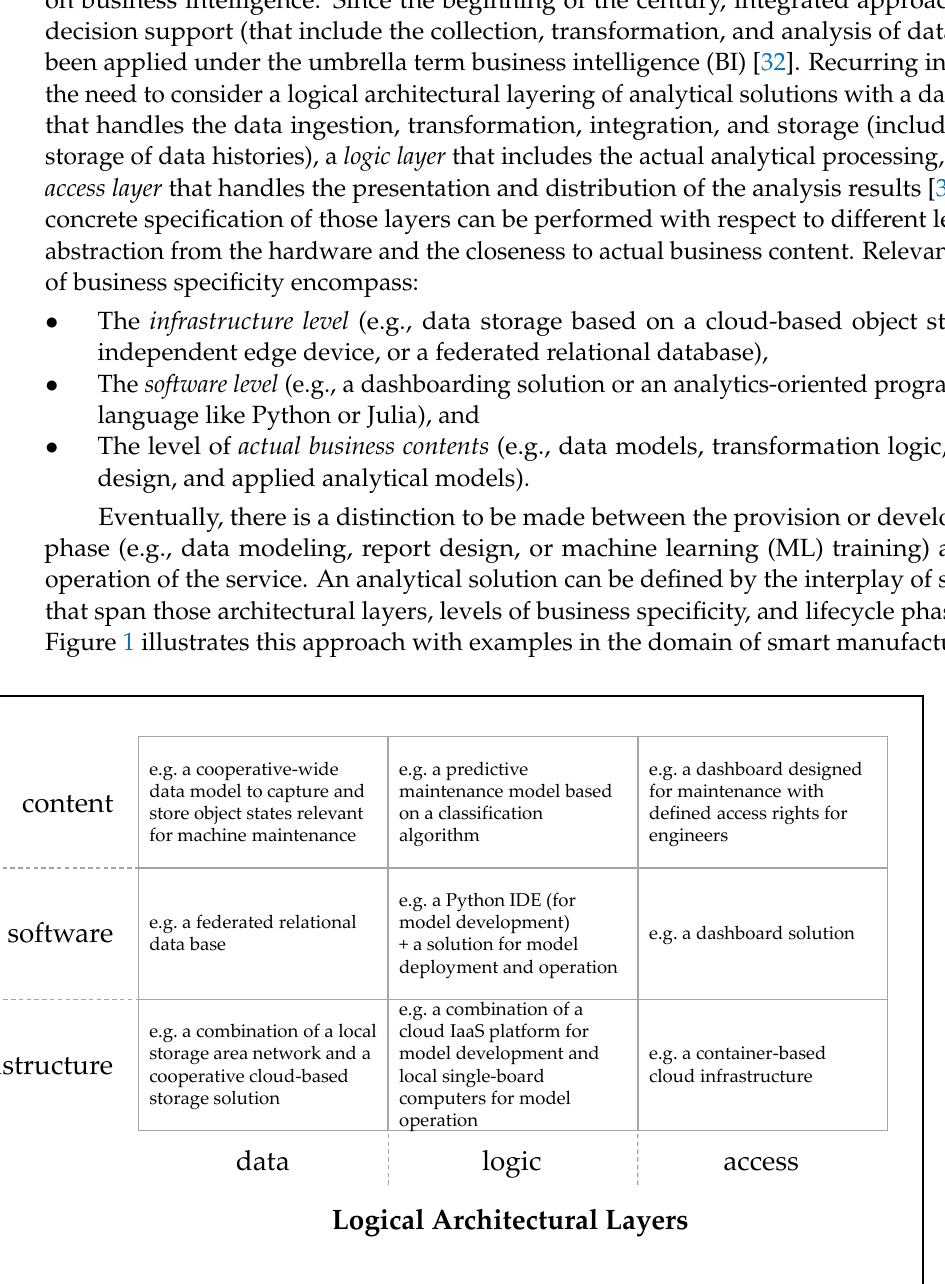
Figure 1. Schema for the specification of an analytics service, based on [34].